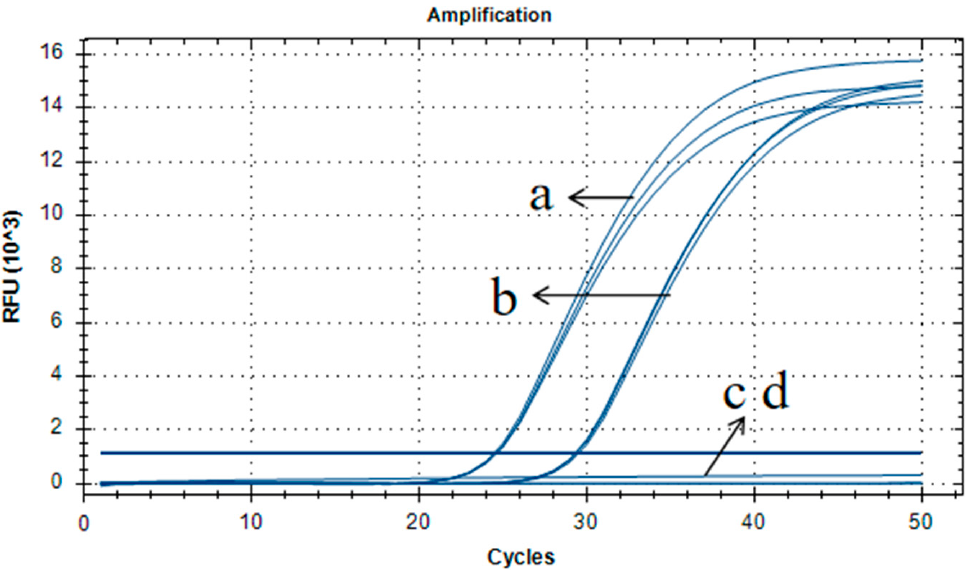
Figure 5. Assessment of applicability for qPCR detection using primer/probe set of Ghpt-QF3/Ghpt- QR3/Ghpt-QP. (a–d) Amplification curve for pFP-hpt, routine testing rice material 2519, non- transgenic rice, and no template control,